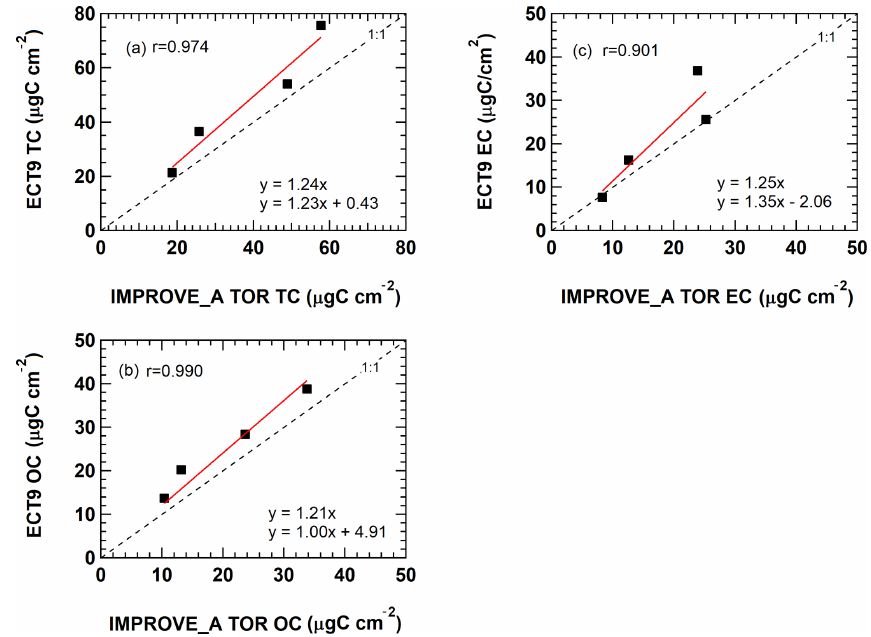
Figure 3. Comparison of (a) TC, (b) OC, and (c) EC concentrations obtained from the same NIST SRM 8785 filters reported by ECCC following the TEA (ECT9) method and by DRI following the IMPROVE_A TOR protocol during the inter-comparison study in